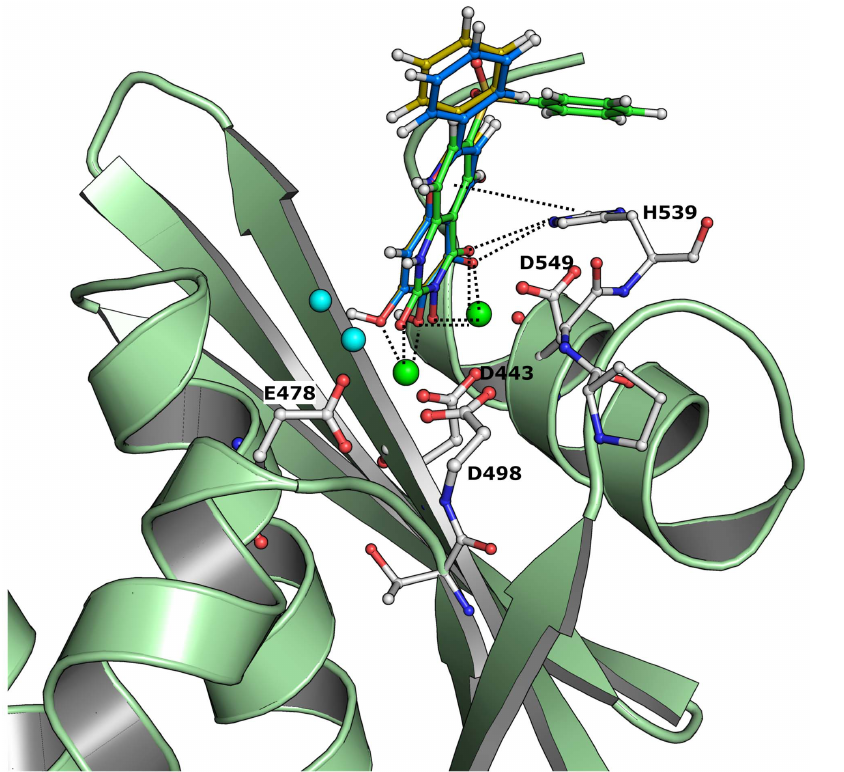
Figure 7. Comparison of Binding mode. Binding mode of ZINC72194123 (blue) and ZINC03871633 (yellow) is shown in ball and stick model with bound ligand (green). Important residues are highlighted, including magnesium ions (green sphere) and water molecules (cyan sphere).